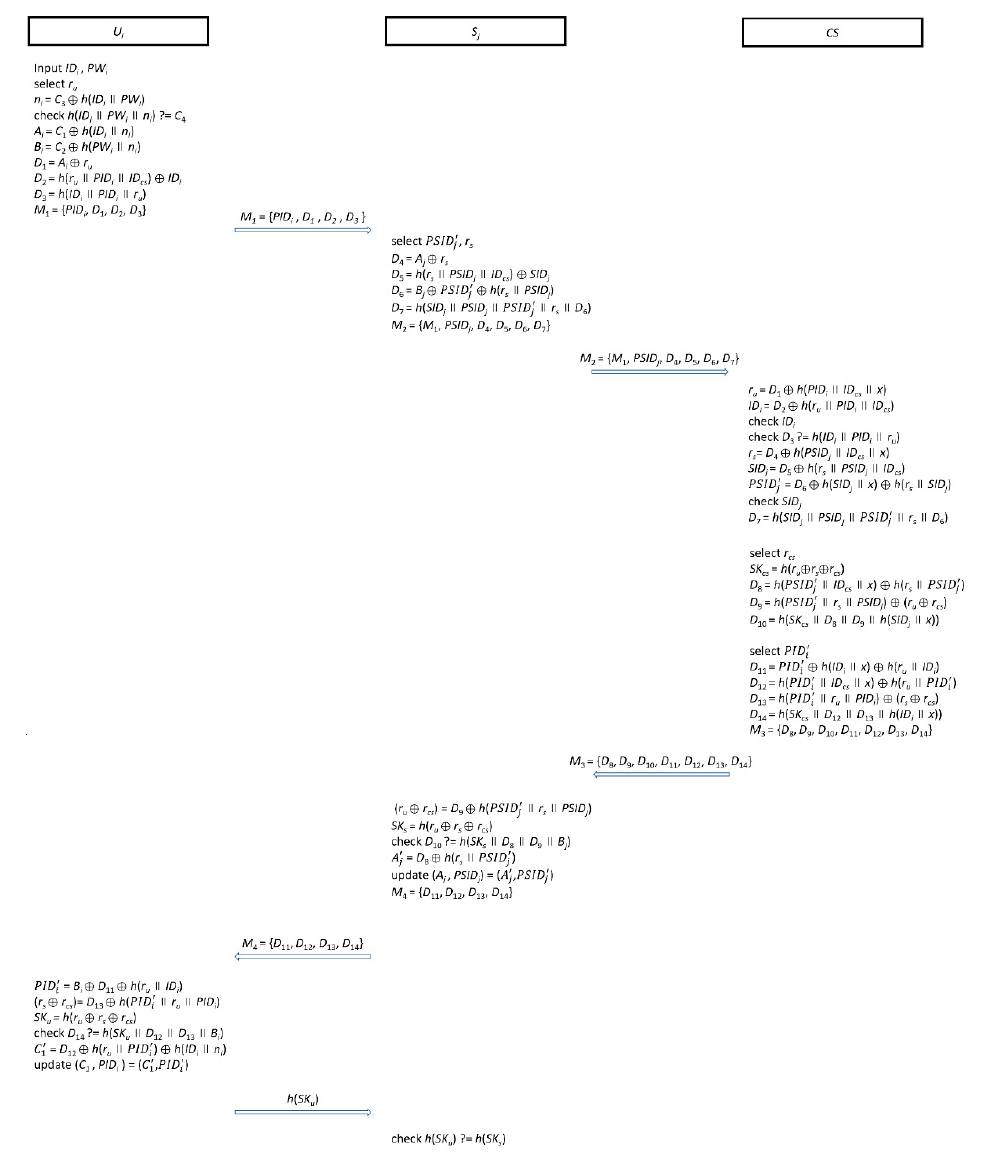
Figure 3. The processes of the authentication phase.